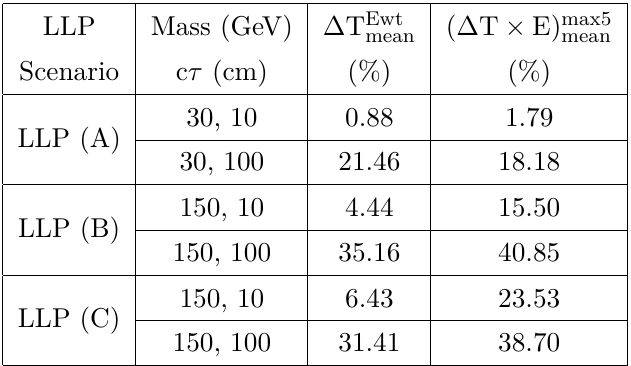
Table 3 . Trigger efficiency for three benchmark masses from the three LLP scenarios with cτ = 10 cm and 100 cm calculated by putting suitable thresholds on the two timing variables to keep the background rate restricted at ≈ 30 kHz when the ECAL timing resolution corresponding to 300 fb − 1 luminosity is applied.